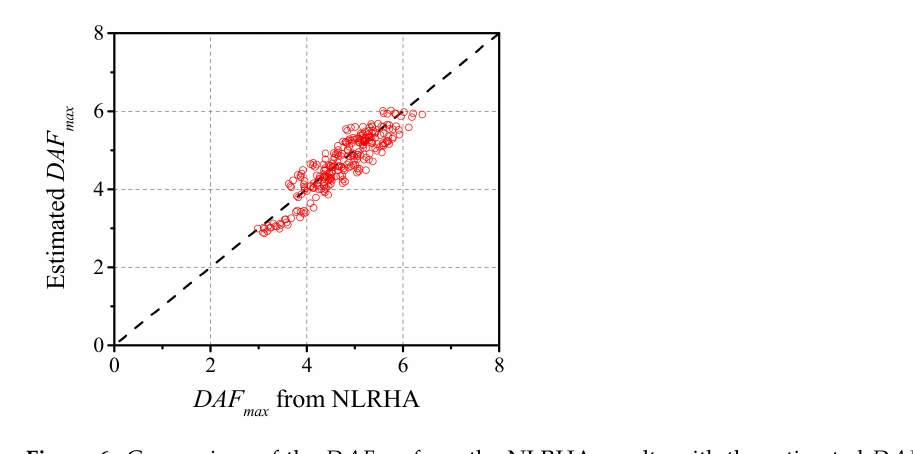
Figure 6. Comparison of the DAF max from the NLRHA results with the estimated DAF max from Equation (1). Table 3. Far-fault ground motions used for the verification (Table A-4A, FEMA [31]) of DAF max (Equation (1)) and the proposed equation for FRS (Equation